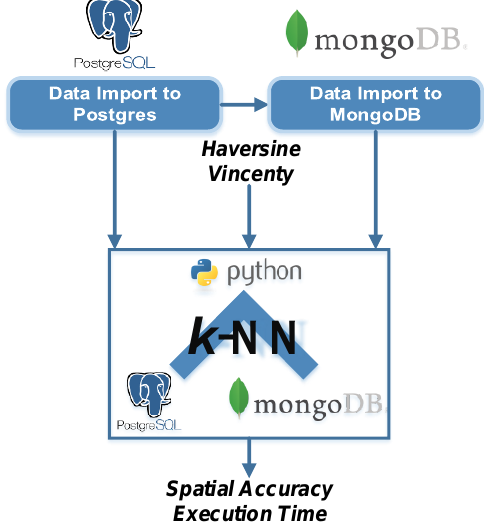
Figure 1 Performance analyses of Postgres and MongoDB regarding the k NN